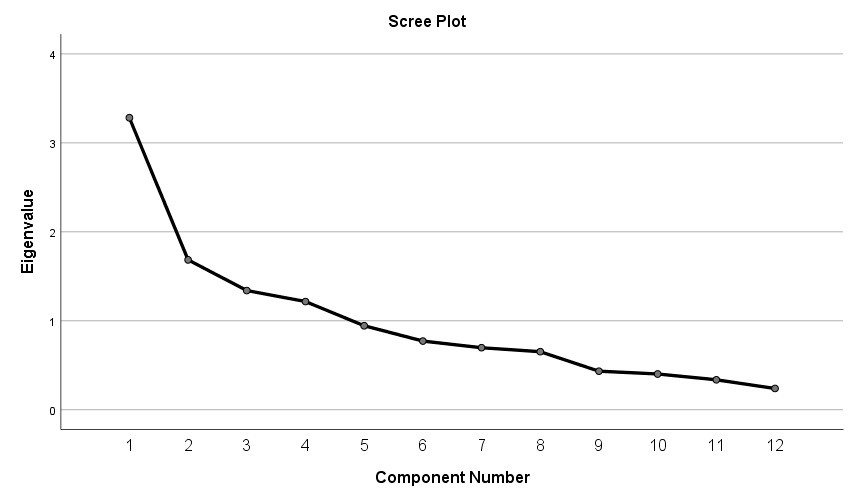
Figure 1. Sedimentation graph of factor components. Table 4. Rotated component matrix of